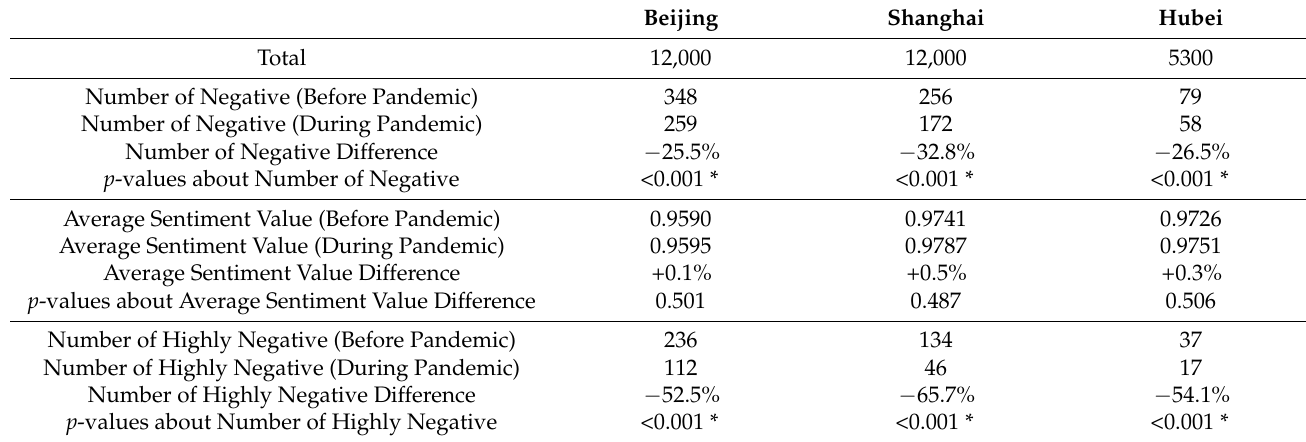
Table 8. Sentiment Analysis Summary for Beijing, Shanghai and